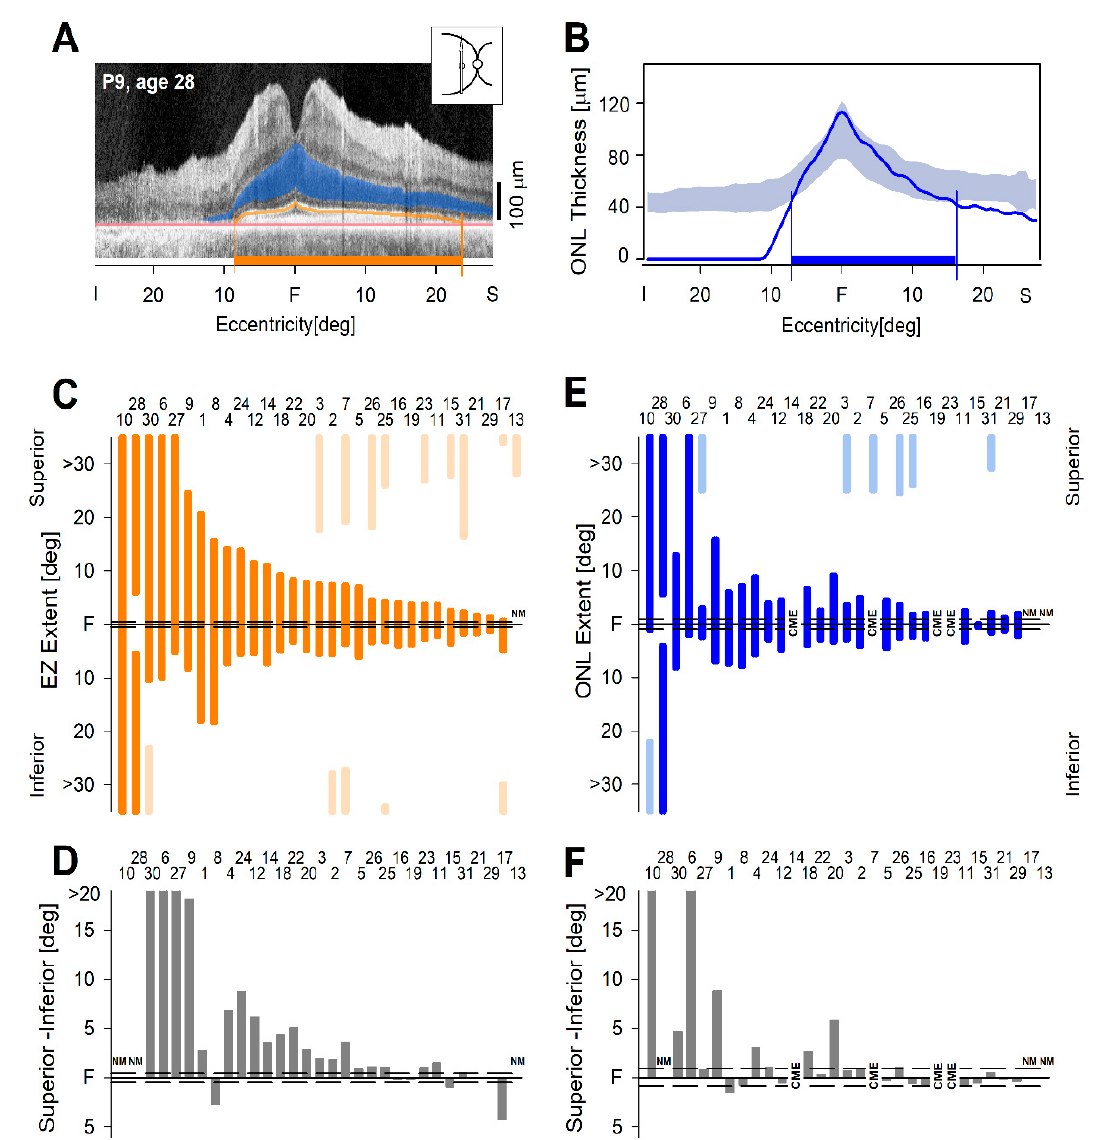
Figure 3. Asymmetry of photoreceptor parameters in vertical OCT scans of RHO -adRP patients. ( A ) Vertical scan across the fovea of a 28-year-old P23H patient; ONL, EZ line, and RPE inner boundary are labeled and colored for visibility: ONL (dark blue), EZ line (orange), RPE (light red). ( B ) Graph of ONL thickness (blue line) and ONL extent (blue bar on horizontal axis) in these regions; light blue band represents normal limits of ONL thickness. ( C ) Quantitation of EZ line extents from fovea into superior retina and fovea into inferior retina. Numbers above the bars in ( C – F ) correspond to patient numbers in Supplementary Table S1. Dark orange bars are the contiguous EZ regions from fovea superiorly and inferiorly. Note: Light orange segments are the eccentrically retained EZ regions at the edge of the scan. ( D ) The di ff erence between EZ extents. ( E ) Quantitation of ONL thickness extents from fovea into superior retina and into inferior retina. Dark blue bars are the contiguous ONL regions from fovea superiorly and inferiorly. Note: Light blue segments are the eccentrically retained ONL regions at the edge of the scan. ( F ) Di ff erences between the ONL extents. CME, cystoid macular edema precluded measurement.